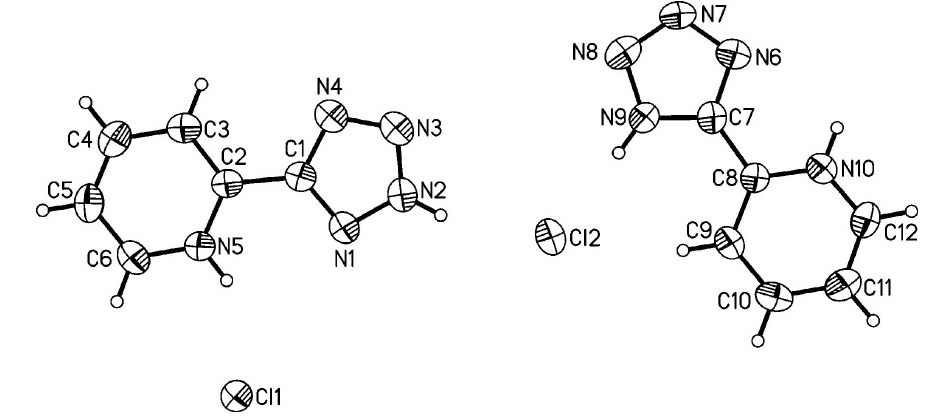
A view of the title compound with the atomic numbering scheme. Displacement ellipsoids were drawn at the 30% probability